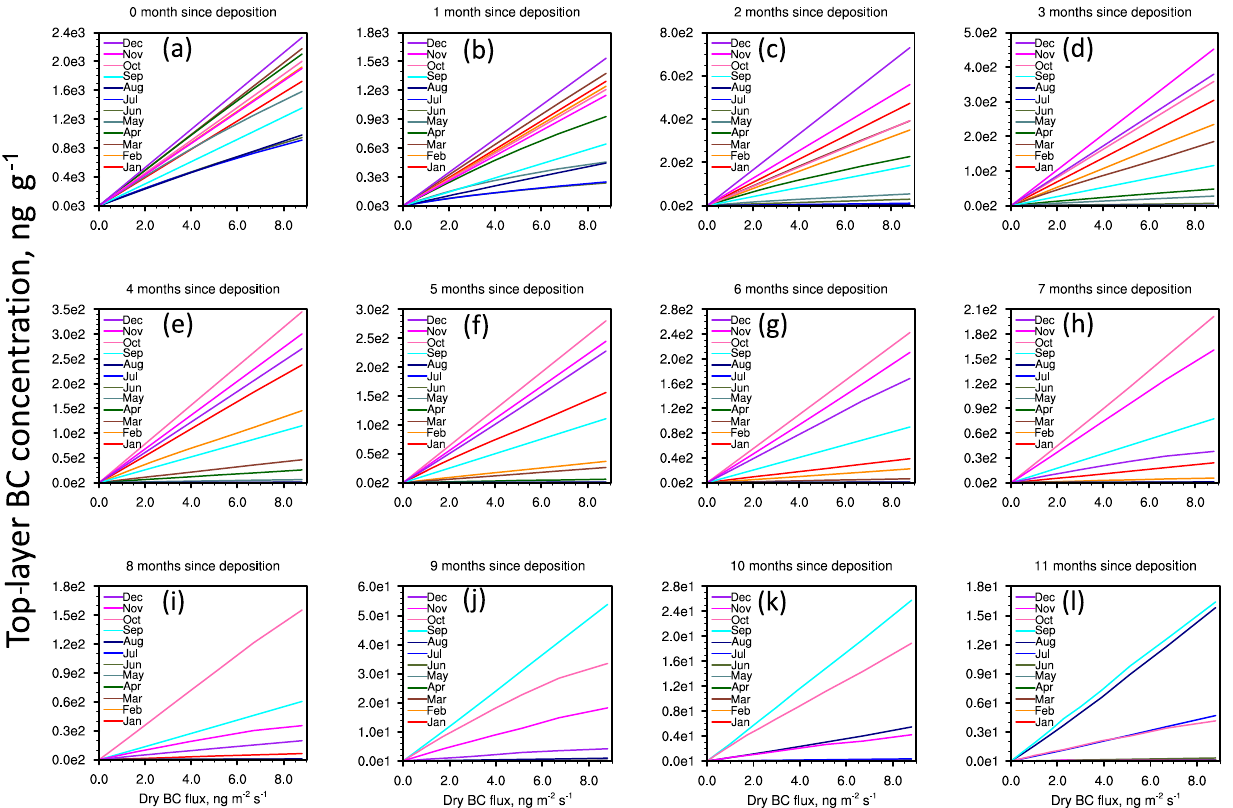
Figure 6. Same as Fig. 5, but showing hydrophobic BC concentration in the top snow layer vs. BC dry deposition flux.